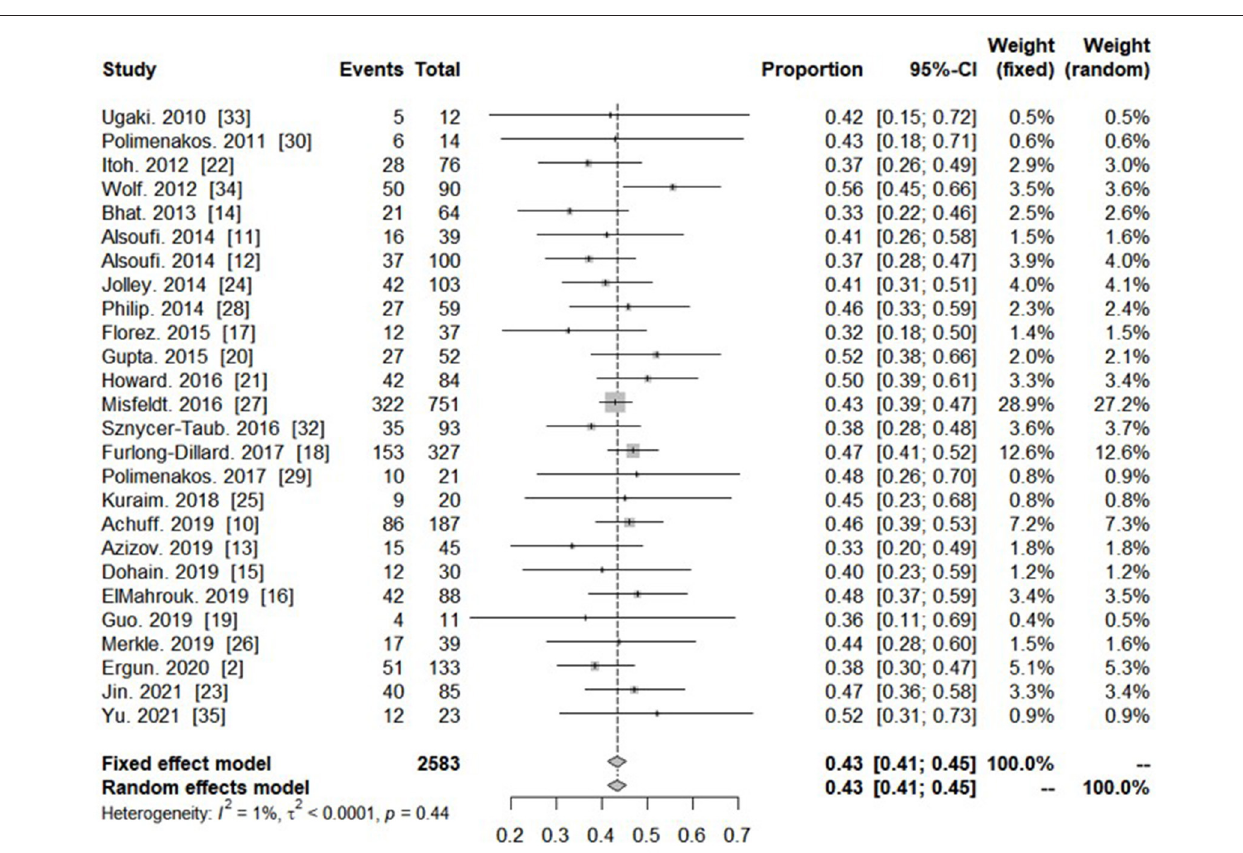
FIGURE 2 | Forest plot showing proportion of survivors with post-cardiotomy extracorporeal membrane oxygenation in all included studies.